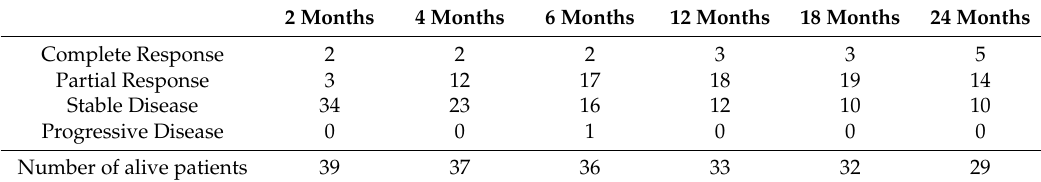
Table 1. Outcome according to the Combined Response Evaluation System (CRES): the categorical attribution of the patients during the 24-months